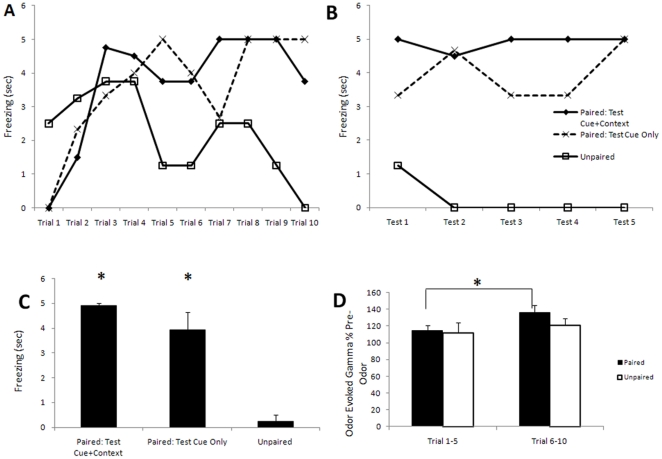
Odor-fear conditioning enhances odor-evoked freezing and odor-evoked gamma oscillations.(A) Paired (Test Cue+Context and Test Cue Only) odor-shock animals significantly increased odor-evoked freezing over the course of odor/shock conditioning trials. Furthermore, during odor only tests the following day, (B) the Paired animals maintained their odor-evoked freezing response when tested either in the context of the conditioning chamber (n = 6) or in a novel context (n = 4). Unpaired animals (n = 4), however, showed significantly less odor-evoked freezing. During the post-conditioning test, the Unpaired animals show no freezing response to the odor. The legend in Figure B applies also to Figure A. (C) Mean level of freezing behavior during the testing session 24 hr post-conditioning across the three groups. (D) Power spectrum analysis showed Paired animals had a significant increase in odor-evoked gamma frequency activity over the course of conditioning trials. Odor-evoked gamma (35–85 Hz) activity was significantly higher on average in the second half of trials compared to the first half in Paired animals. There was no change in Unpaired animals. Asterisks signify significant difference between groups.